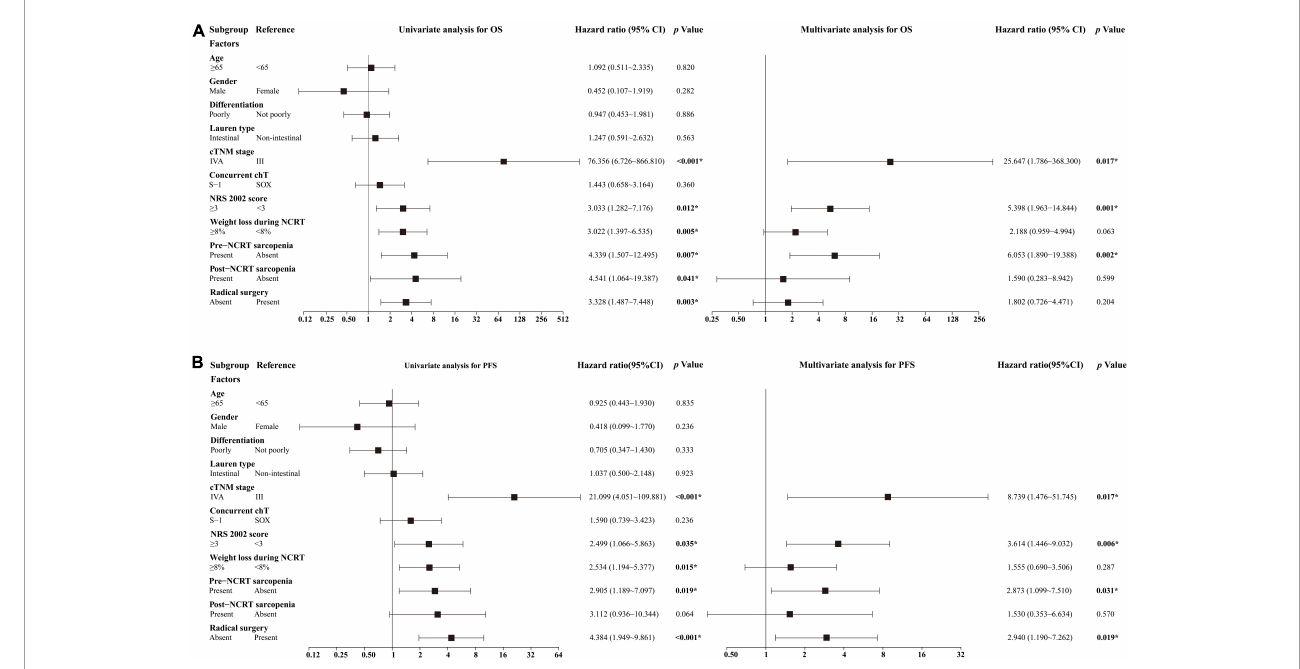
FIGURE4 Results of univariate and multivariate analyses for (A) OS and (B) PFS. *Statistically significant values are given in bold. chT, chemotherapy; NCRT, neoadjuvant chemoradiotherapy; OS, overall survival; PFS, progression-free survival; SOX, S-1 and